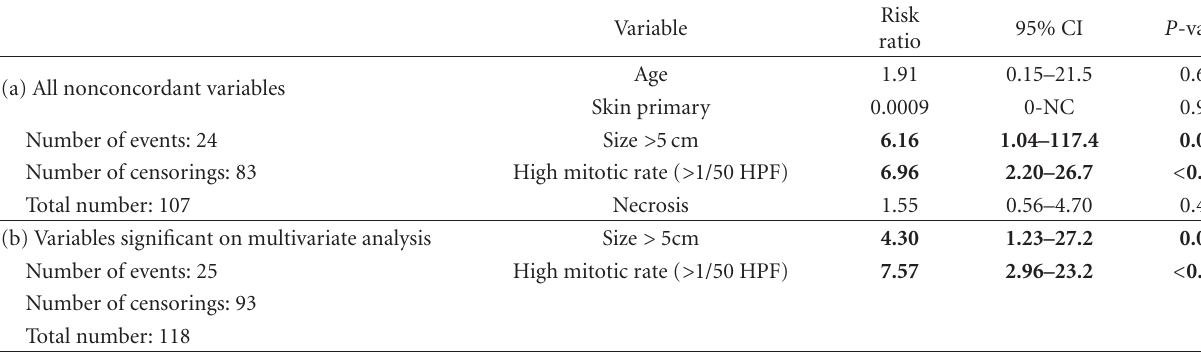
Table 3: Multivariate analysis of clinical and histologic factors related to PEComa-NOS recurrence.